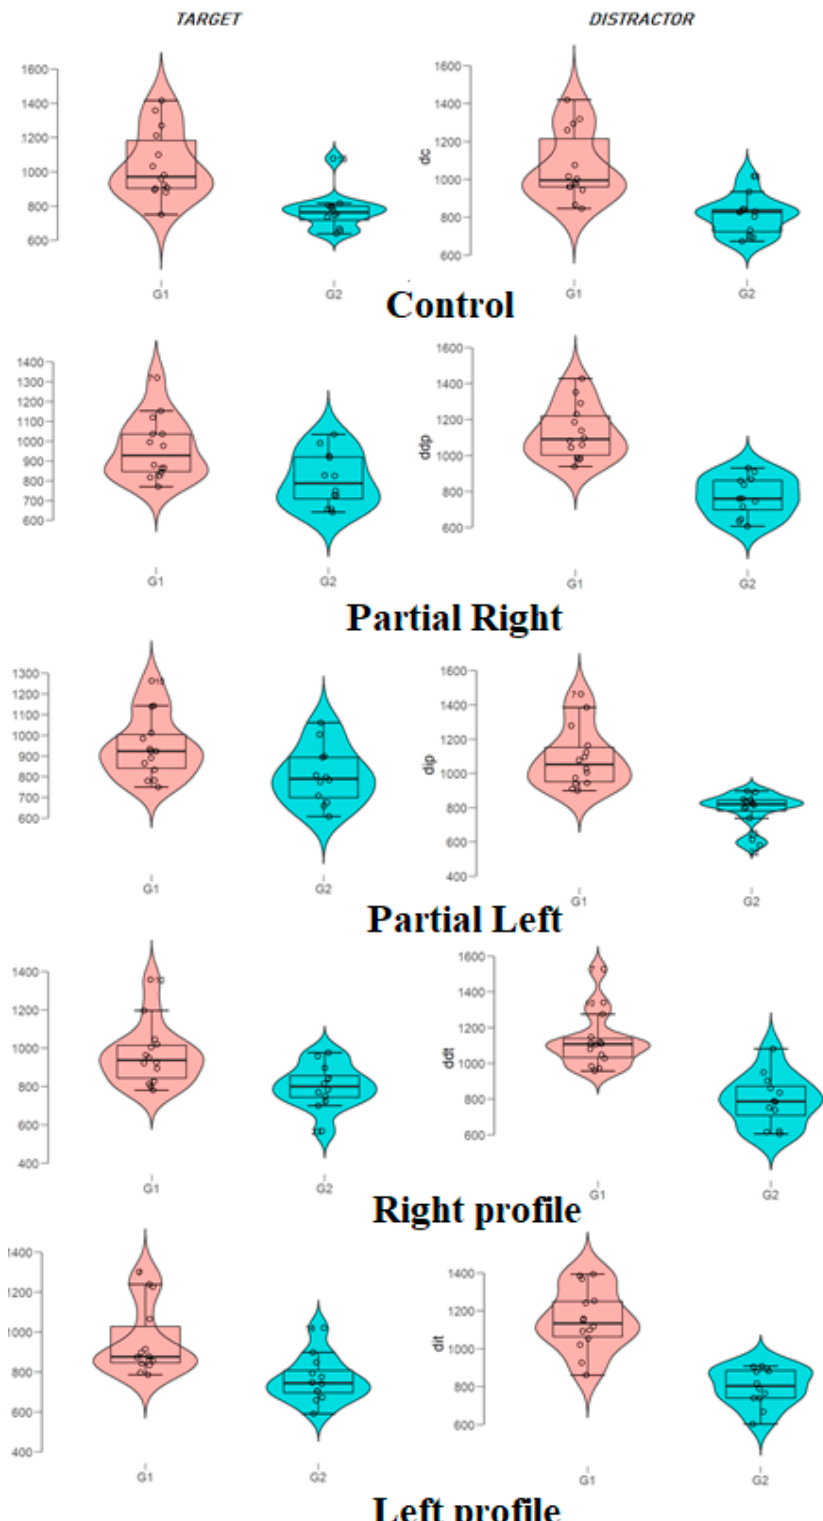
Figure 3. Box and whiskers diagram for the di ff erent conditions according to the cluster group.